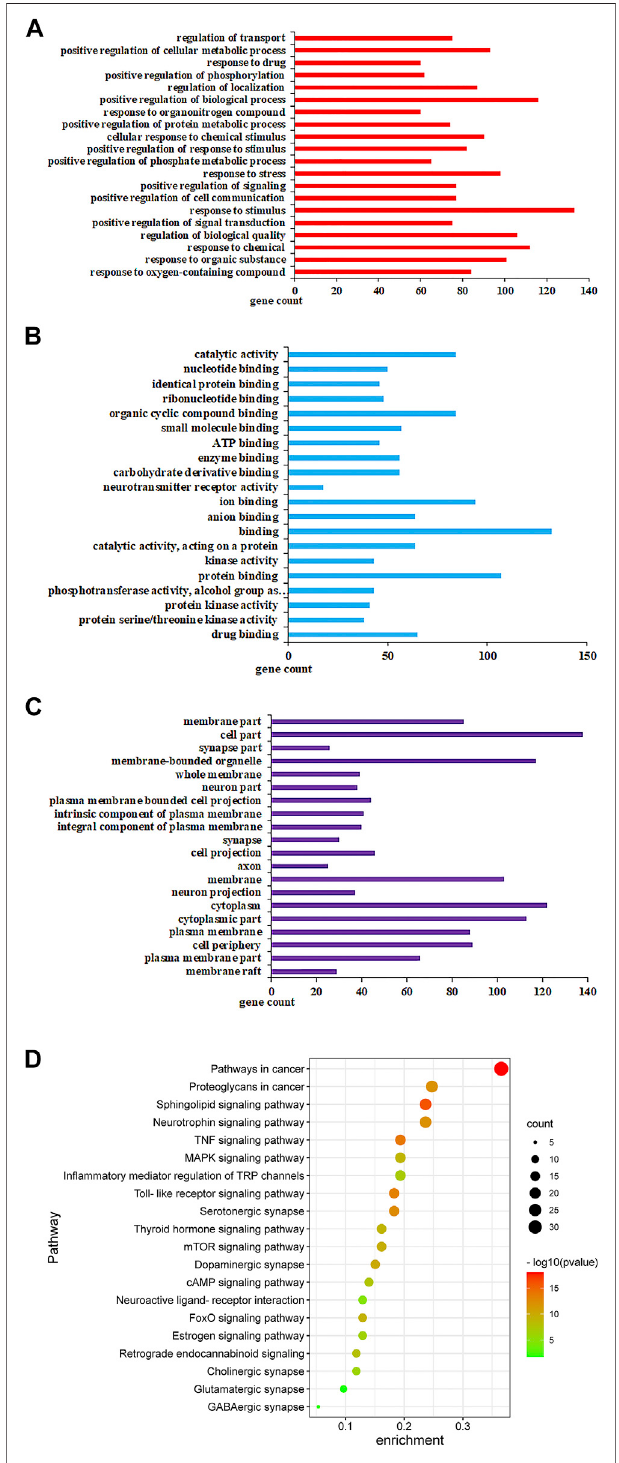
FIGURE 6 | GO analysis and KEGG analysis of potential targets for primary active ingredients from ZZX against PTSD. (A) Biological processes (BP); (B) molecular function (MF); (C) cellular components (CC); (D) KEGG enrichment analysis.